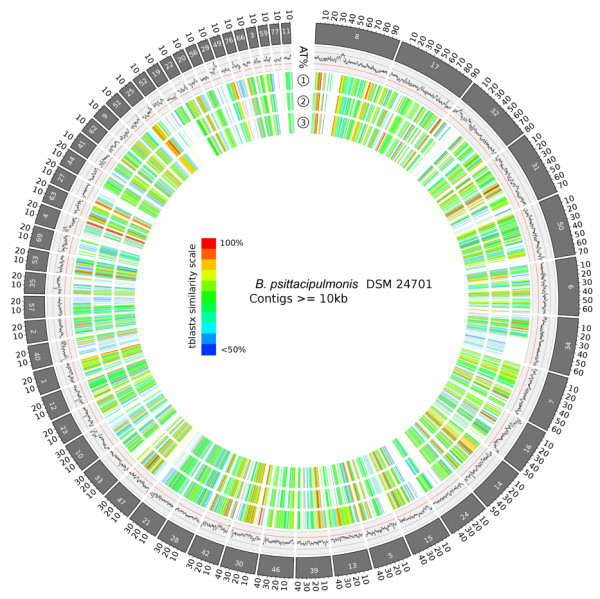
Ring diagram showing blast similarity at the protein level and AT content. External ring displays the DSM 24701 ordered contigs that are greater or equal to 10 kb. The AT% ring displays the AT% computed by using a sliding window of 1 kb. Axes range from 40% to 80%. Inner rings (1), (2) and (3) display the similarity scores at the protein level (tblastx, e-value cutoff 0.1). The compared species are (1) B. avium 197 N, (2) T. asinigenitalis MCE3 and (3) T. equigenitalis ATCC 35865.